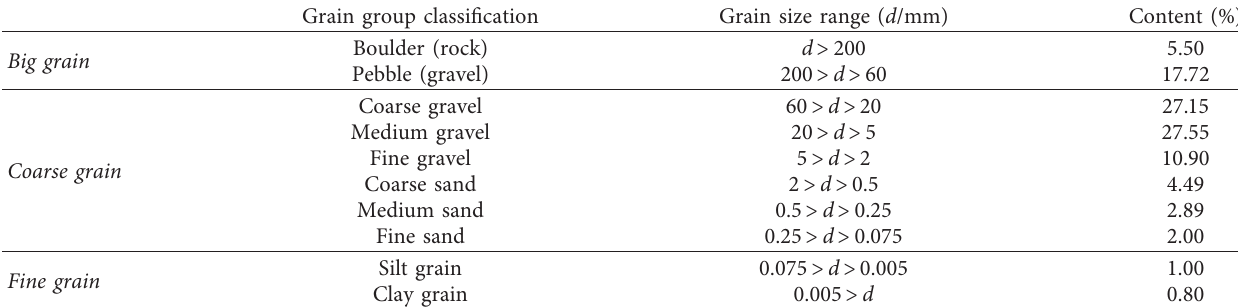
Table 3: Content of each grade of grains in the dump soils